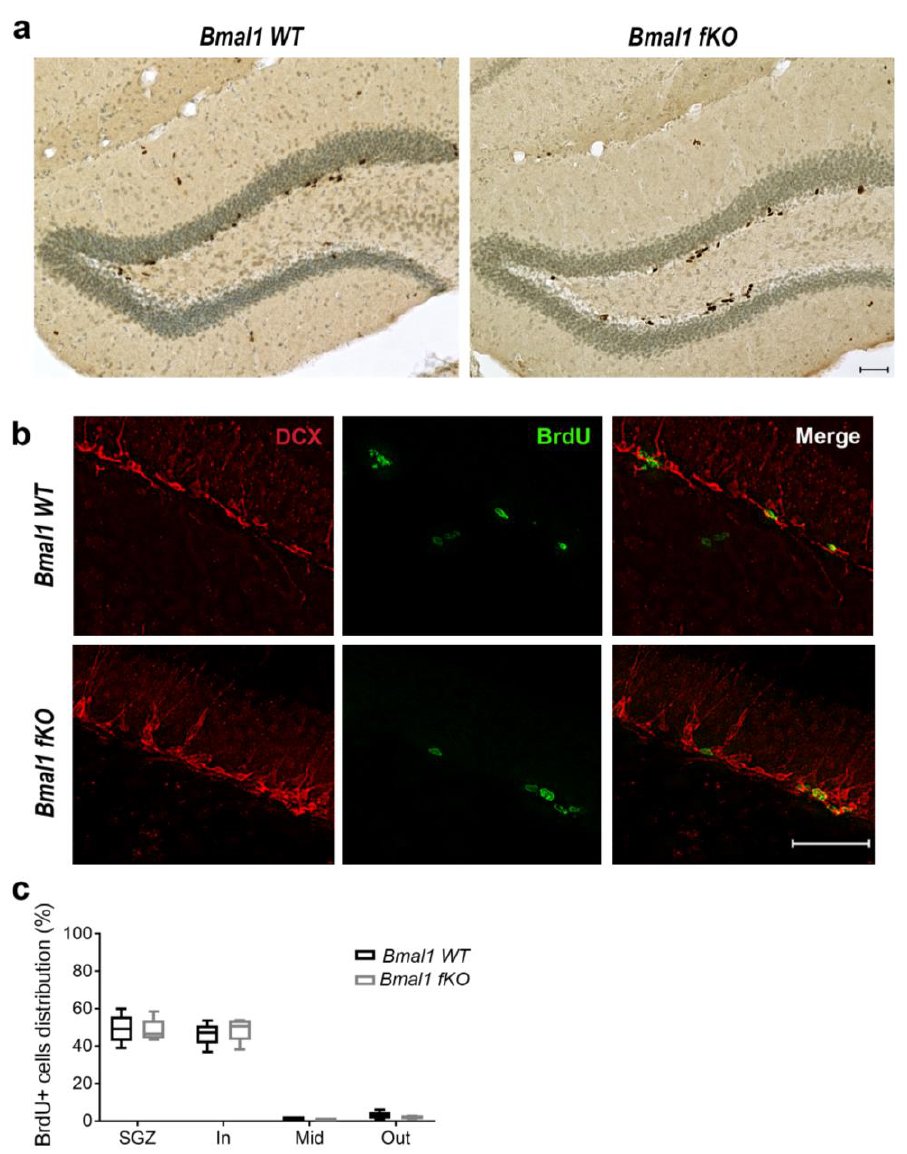
mice ( p = 0.3, n = 5 per genotype).